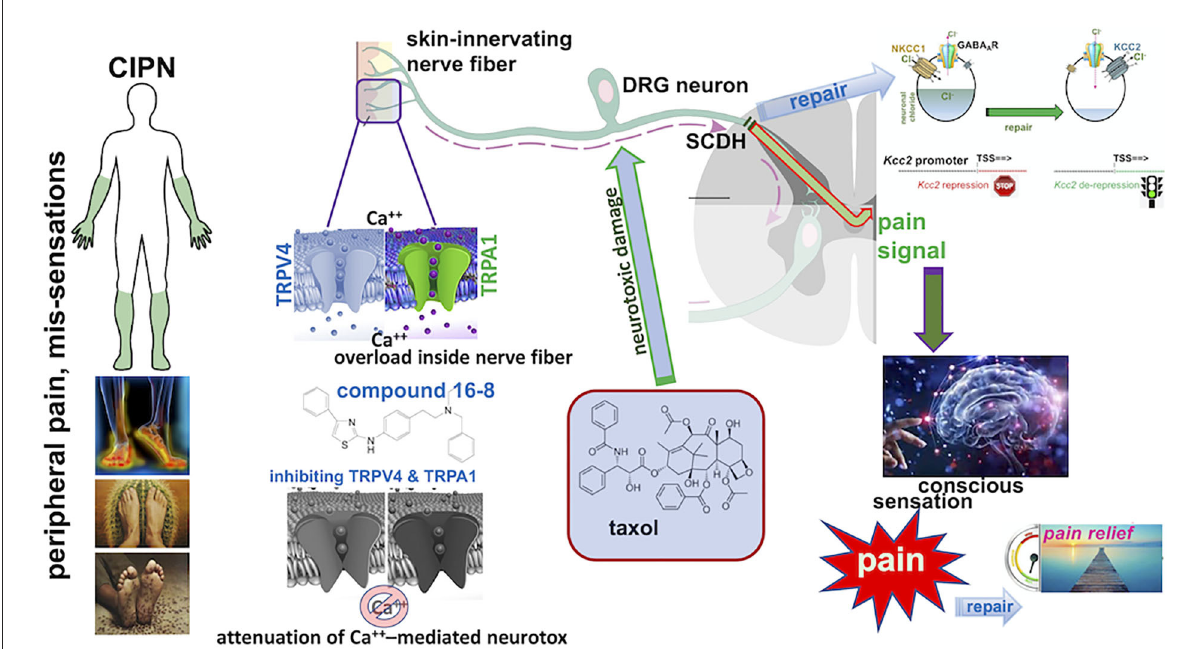
FIGURE3 Summary schematics of Taxol CIPN-pain effectively treated with topical compound 16-8 and its beneficial impact on spinal cord dorsal horn (SCDH) neural circuit function. (Left) Depiction of the typical “glove and stocking” distribution of chemotherapy-induced painful peripheral neuropathy (CIPN), and frequent subjective symptoms (below). (Middle) The pathophysiology of CIPN involves calcium overload in skin-innervating sensory neurons in the dorsal root ganglion (DRG) caused by treatment with neurotoxic chemotherapeutic agents, such as Taxol. (Right) Nerve damage to C-type nociceptors in the DRG and their peripheral pain-conducting C-fibers causes sensitization of pain neural circuits which transmit via spinal afferents to the brain/cortex, for perception of pain. This involves attenuated expression of Kcc2 in the spinal cord dorsal horn, thus corrupting the pain neural circuit by rendering its gate function overly excitable and “leaky”. Topical application to skin of compound 16-8 will inhibit TRPV4 and TRPA1 calcium-permeable ion channels in skin-innervating nerve fibers and attenuate the calcium overload-mediated neurotoxicity to DRG neurons. As a result, there is remarkable analgesia in a preclinical mouse model, and also effective repair of attenuated Kcc2 expression in the SCDH, which resulted from neurotoxic injury of afferents. Upon effective treatment via blocking peripheral TRPV4 and TRPA1 channels, Kcc2 gene expression is renormalized in the SCDH (Right)